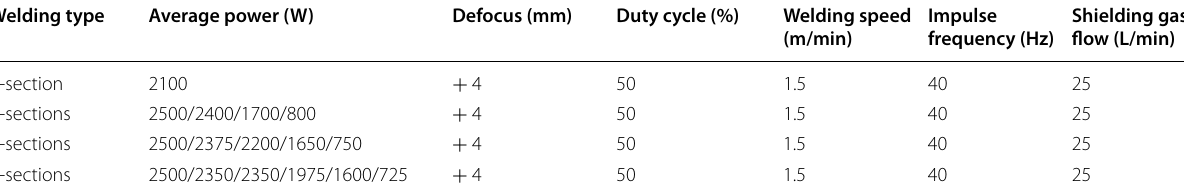
Table 2 Process parameters of different welding methods Welding type